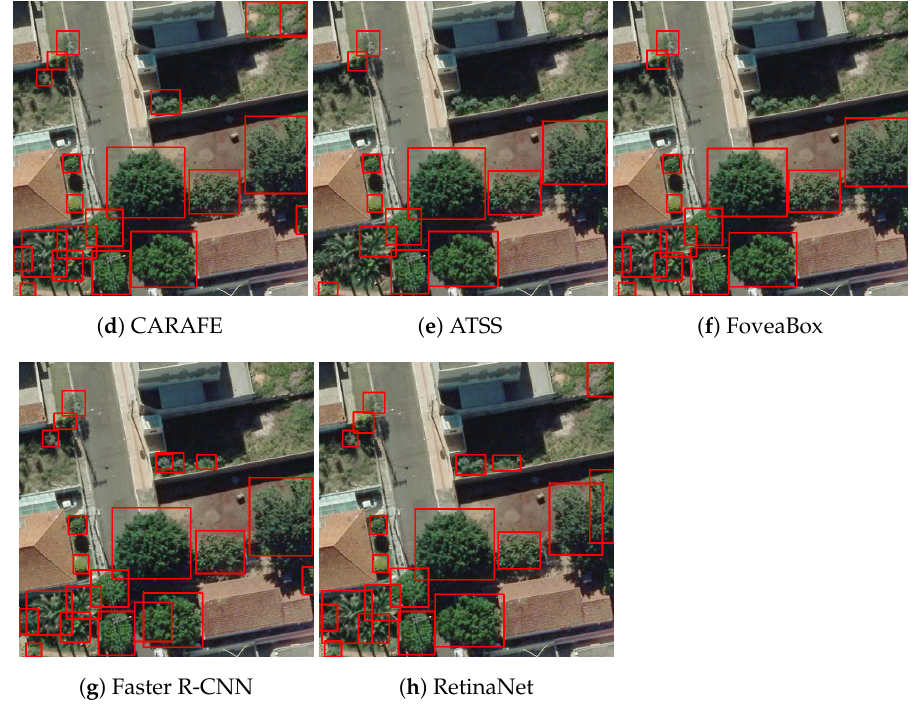
Figure 13. Tree detection with the top five methods, RetinaNet, and Faster R-CNN: performance in a high density scenario.